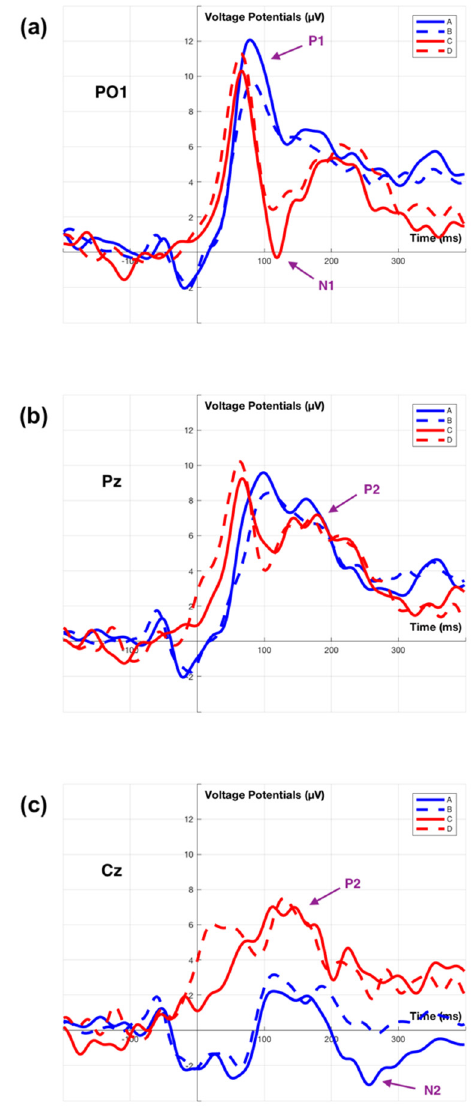
Figure 8. Grand average ERP of channel ERP plots. Plot ( a ). Grand average ERP of channel PO1. Plot ( b ). Grand average ERP of channel Pz. Plot ( c ). Grand average ERP of channel Cz. Signal A, B, C, D is consistent with Figure 7.